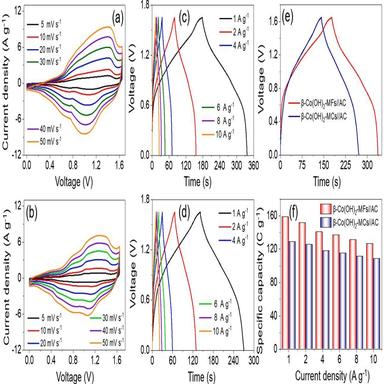
The CV profiles of (a) β-Co(OH)2 MFs//AC HSC and (b) β-Co(OH)2 MCs//AC HSC over diverse scan rates, the GCD profiles of (c) β-Co(OH)2 MFs//AC HSC and (d) β-Co(OH)2 MCs//AC HSC at diverse current loads, (e) the GCD profiles of both HSCs at 1 A g− 1 , and (f) the rate performance of β-Co(OH)2 MFs//AC and β-Co (OH)2 MCs//AC HSCs.